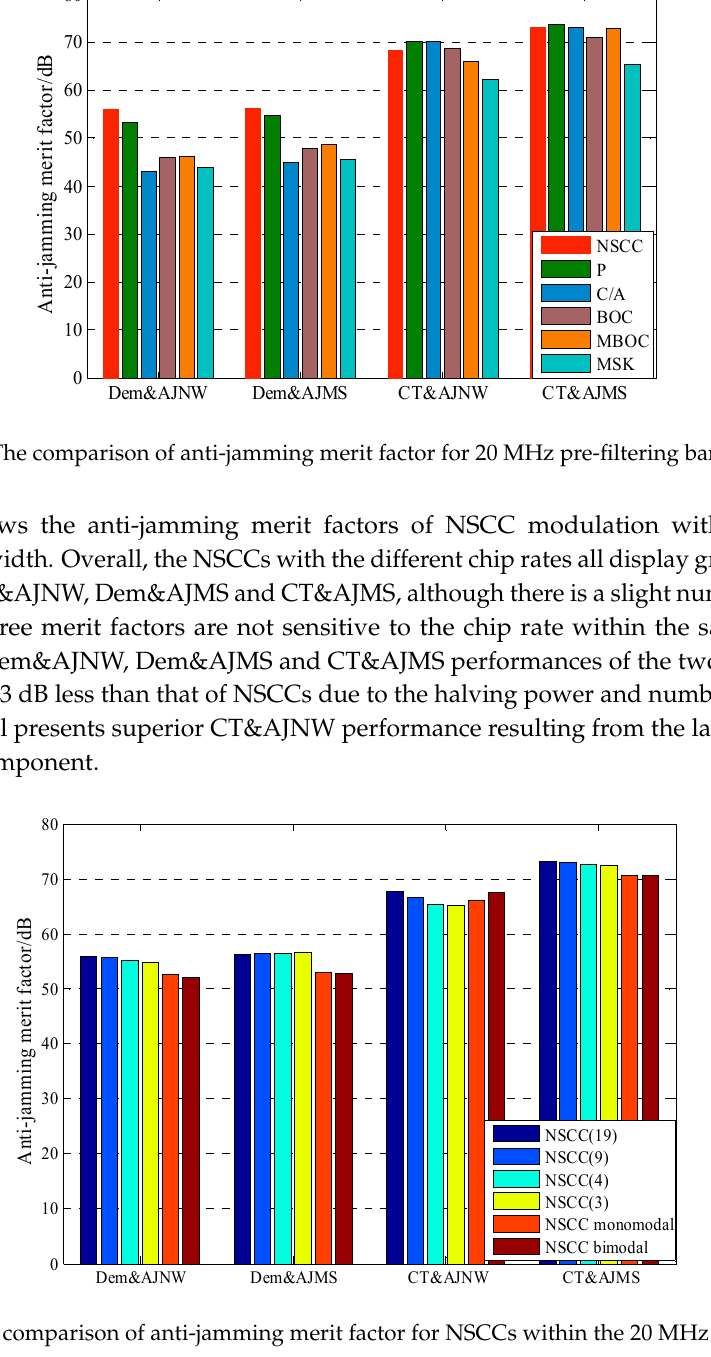
( d ) Figure 10. Multipath error envelops of pre-filtering bandwidth of 2 MHz ( a ), 4 MHz ( b ), 10 MHz ( c ), 20 MHz ( d ), a = 0.1, d = 0.1 chip. According to the Nyquist Sampling Theorem, we computed the envelopes of a signal only when the pre-filtering bandwidth is larger than the main lobes bandwidth. For the 2 MHz pre-filtering bandwidth, the MSK presents better multipath mitigation capability than C/A, but worse than the other modulation schemes investigated. As the pre-filtering bandwidth increases, the MPEEs of the legacy signals and the NSCC decrease. The greater bandwidth allows more high-frequency component in the EML discriminator, and the detailed component is demonstrated